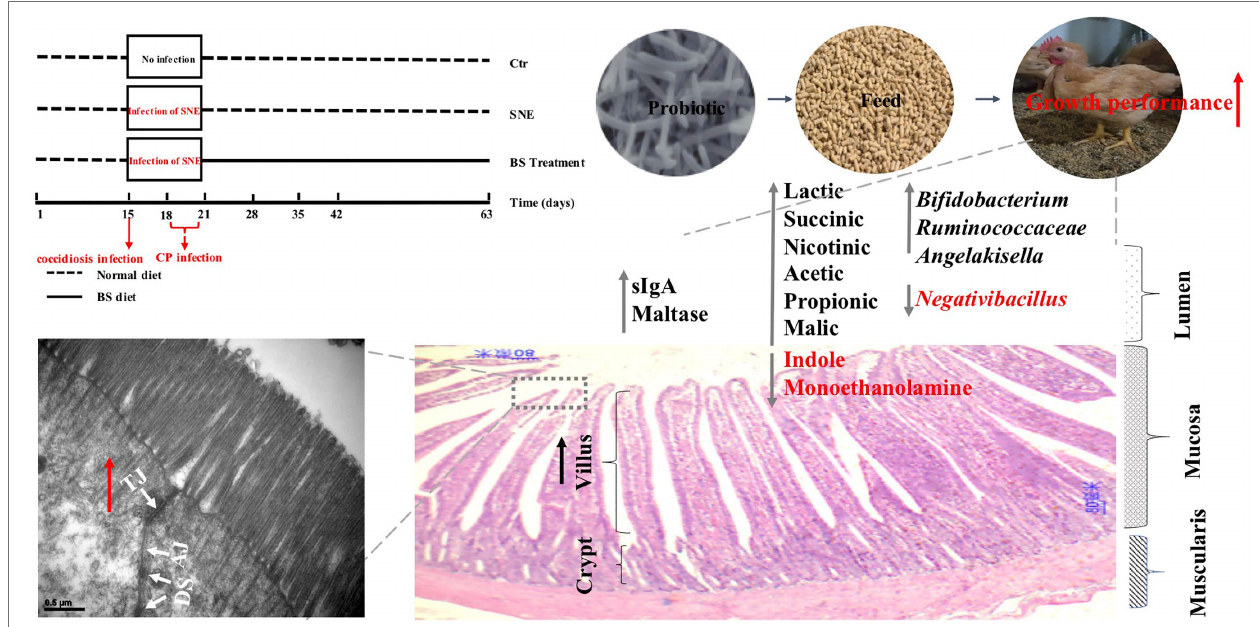
FIGURE 8 | Graphical summary of the effect of probiotic Bacillus subtilis DSM29784 (BS) exerts a protective effect against subclinical necrotic enteritis in broilers. BS reduces the risk of declined growth performance in chickens with SNE by enhancing exoenzyme secretion, intestinal barrier functions, and promoting the presence of beneficial commensal microorganisms and their metabolites in the intestine. SNE, subclinical enteritis; sIgA, secretory immunoglobulin A; CP, Clostridium perfringens ; TJ, tight junction; AJ, adherens junction; DS, desmosomes. Ctr group, basal diet in control group; SNE group, basal diet + SNE (20-fold dose coccidiosis vaccine) +1 ml of Clostridium perfringens (2 × 10 8 cfu/ml coinfection); BST group, basal diet (days 1–21) + 1 × 10 9 colony-forming units (cfu)/kg BS diet (days 22–63) +